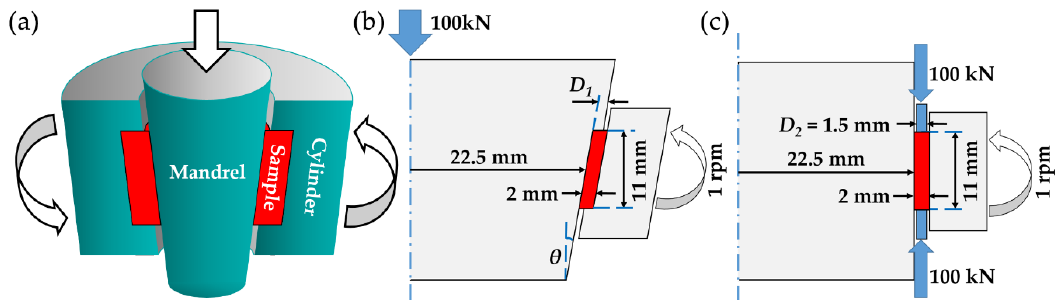
Figure 1. The principles and the geometry of tube high-pressure shearing ( t -HPS): ( a ) schematic illustration of t -HPS pressurizing by the wedge effect (adapted from [6], with permission from the patent holder, Nanjing University of Science and Technology); ( b ) the geometry of the t -HPS pressurizing by the wedge effect, with half cone angle θ and the depth of the concave on the cylinder D 1 ; ( c ) the geometry of the t -HPS pressurizing on both ends of the tube, with the wall thickness of the pressurizing ring D 2 . The parameters with a numerical value given in the figures remain constant in the investigation of the present work, and the other symbolized parameters are variables.